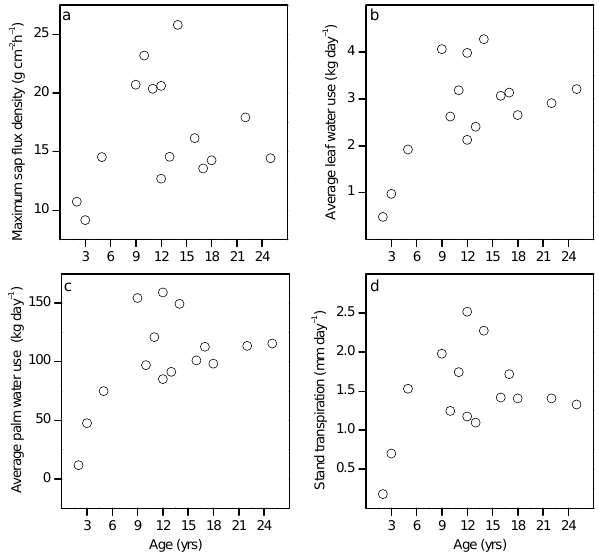
Figure 3. The change of maximum hourly sap flux density (a) , aver- age leaf water use (b) , average palm water use (c) and stand transpi- ration (d) over stand age. Data of the different levels derived from simultaneous sap flux measurements on at least 13 leaves per stand; values of three sunny days